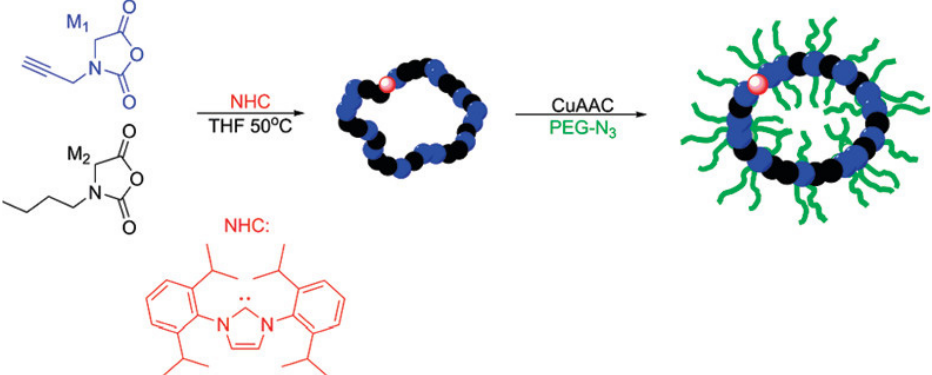
Figure 9. Synthesis and Characterization of Cyclic Brush-Like Polymers by N -Heterocyclic Carbene-